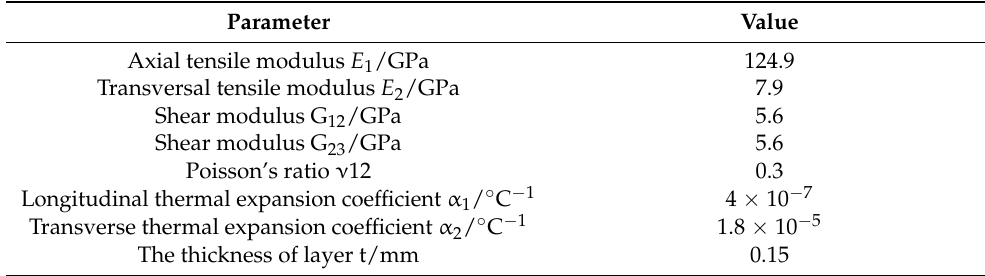
Table 1. Material parameters of the bistable composite laminate. Parameter Value